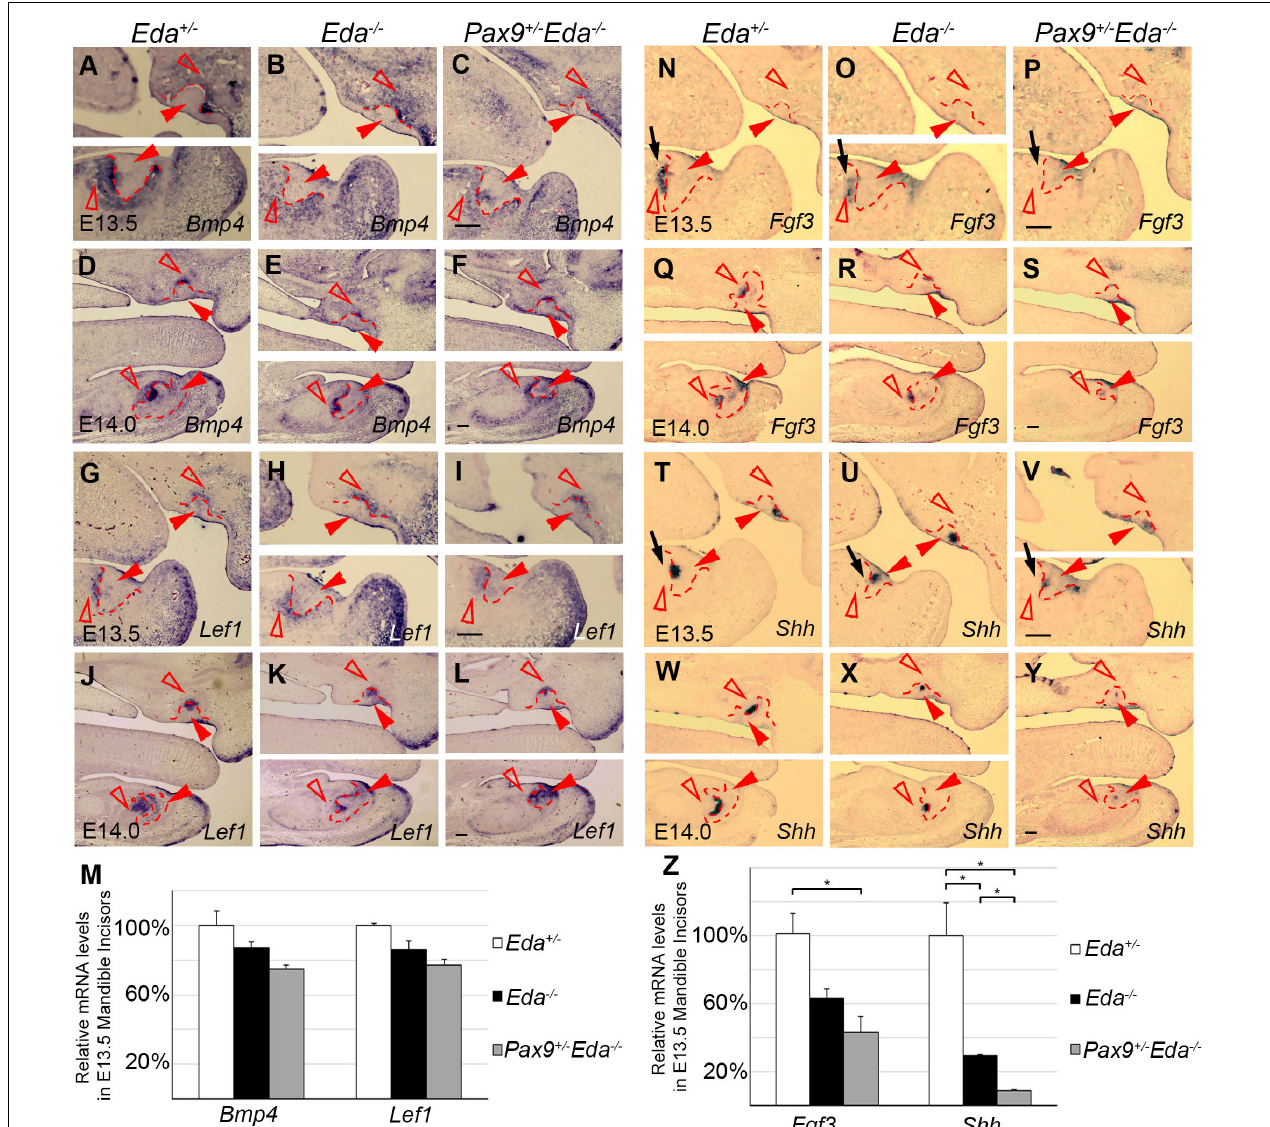
FIGURE 3 | Comparison of incisor molecular marker expression in E13.5 and E14.0 tooth germs. The mRNA expression of Bmp4 and Lef1 were shown in Eda + / − , Eda − / − , and Pax9 + / − Eda − / − mutants by in situ hybridization at E13.5 (A–C,G–H) , as well as at E14.0 (D–F,G–L) . The expression of Fgf3 and Shh was shown in Eda + / − , Eda − / − , and Pax9 + / − Eda − / − mutants by in situ hybridization at E13.5 (N–P,T–V) , as well as at E14.0 (Q–S,W–Y) . Scale bar presented 100 µ m, black arrows indicate mandibular incisor tooth germ. Red solid arrowheads indicate dental epithelia and red open arrowheads indicate dental mesenchyme. Red dashed lines indicate the boundary of incisor tooth germ mesenchyme and epithelia. (M,Z) The relative mRNA levels of Bmp4 , Lef1 , Fgf3 , and Shh were analyzed by quantitative RT-PCR using the microdissected E13.5 mandibular incisors ( n = 3). Error bars indicate SEM, * P < 0.01.